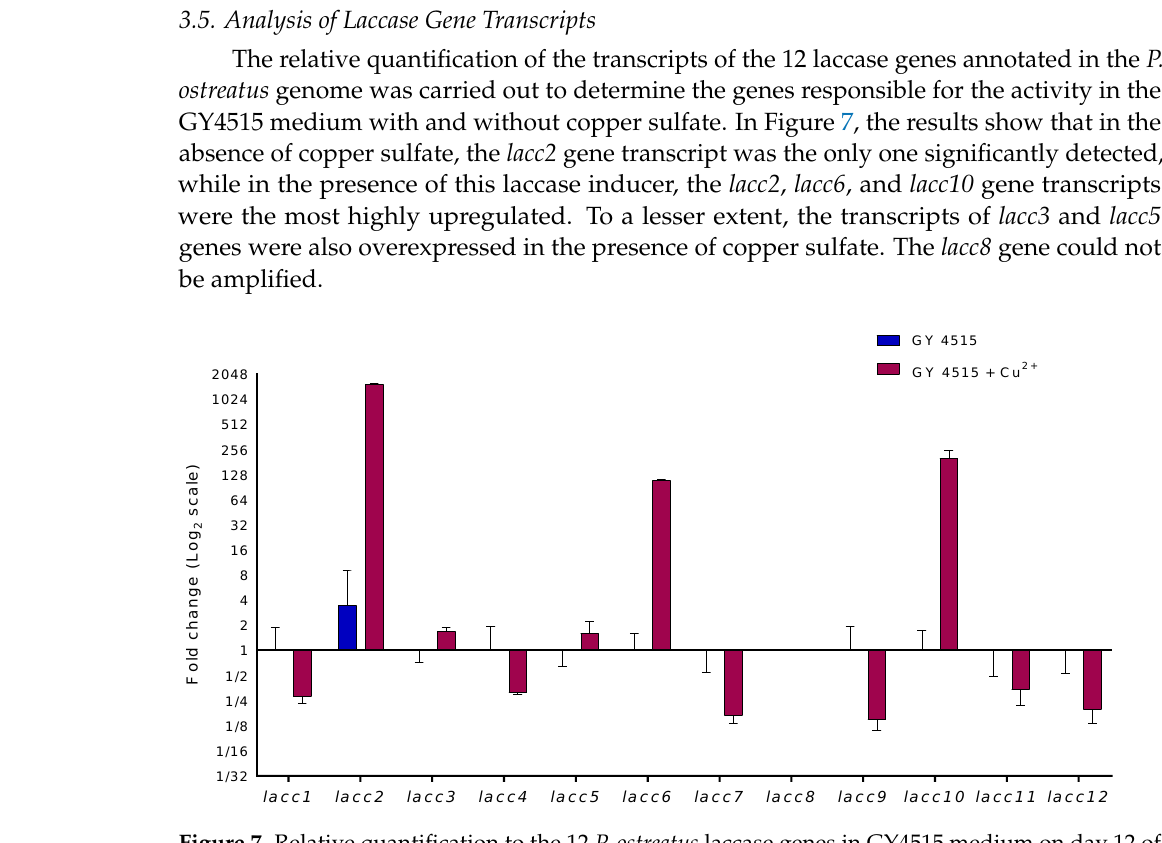
Figure 7. Relative quantification to the 12 P. ostreatus laccase genes in GY4515 medium on day 12 of culture. Blue bar: GY4515 without copper sulfate; red bar: GY4515 with copper sulfate, 1 mM.